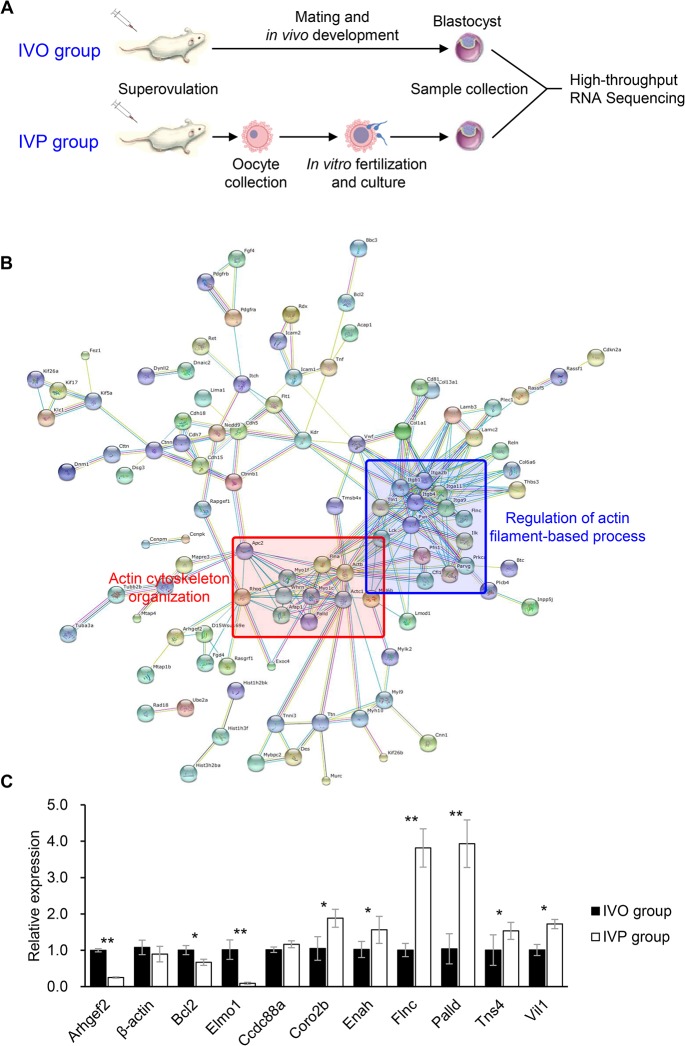

In vitro-produced (IVP) blastocysts are characterized by abnormal actin cytoskeleton organization.(A) Overview of the experimental design. Blastocysts were collected after either mating and in vivo development (IVO group) or in vitro fertilization and culture (IVP group). (B) Protein-protein interaction (PPI) network. Differentially expressed genes (DEGs) in the IVO and IVP blastocysts showed a tightly interconnected network, as observed from a web-based search of the STRING database. (C) Expression of actin-associated genes in the IVP and IVO blastocysts detected by quantitative real-time PCR analysis. The asterisks (* or **) in each column represent statistically significant differences (P < 0.05 and P < 0.01, respectively).